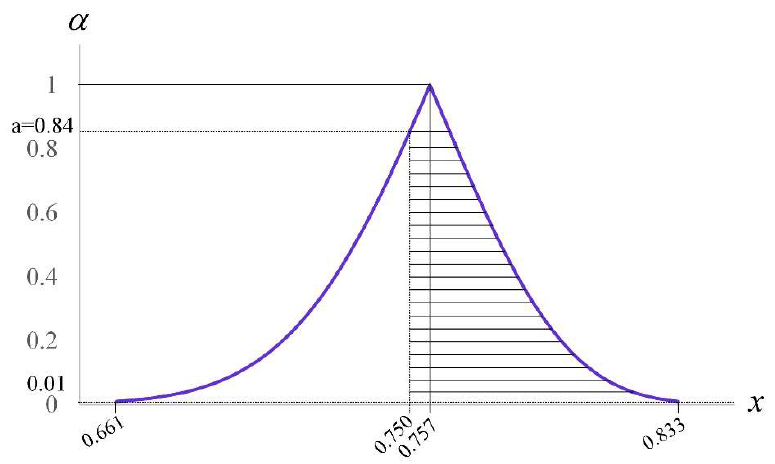
Figure 3. Membership functions η ( x ) with (cid:101) C Lm = ∆ ( C L , C M , C R ) = ∆ ( 0.661,0.757,0.833 ) and vertical line x = 0.750.